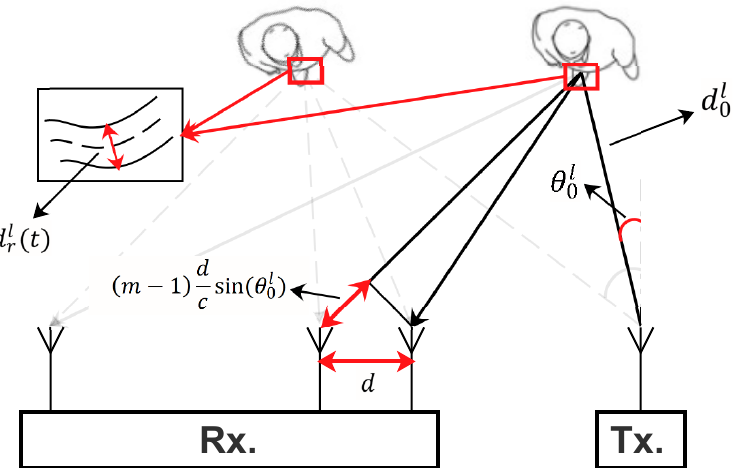
Figure 1. Signal receiving model of array